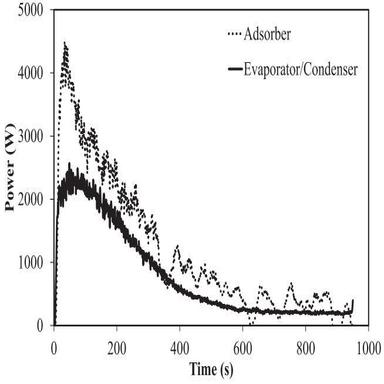
Power in the adsorber and evaporator during discharge phase.